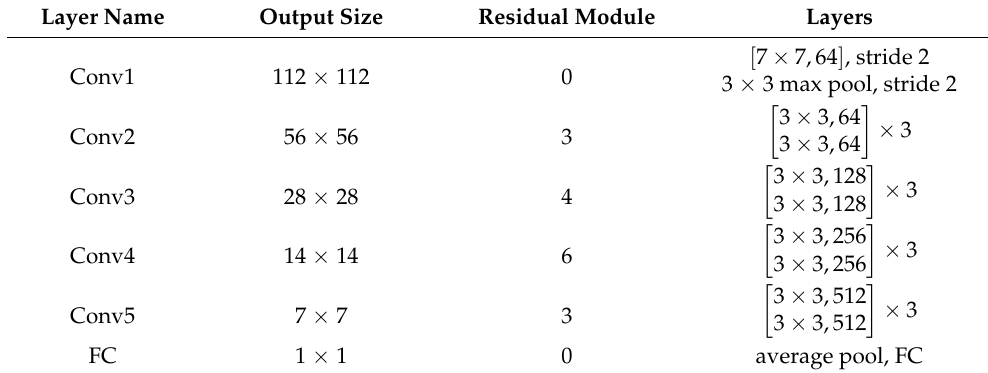
Table 1. The structure of